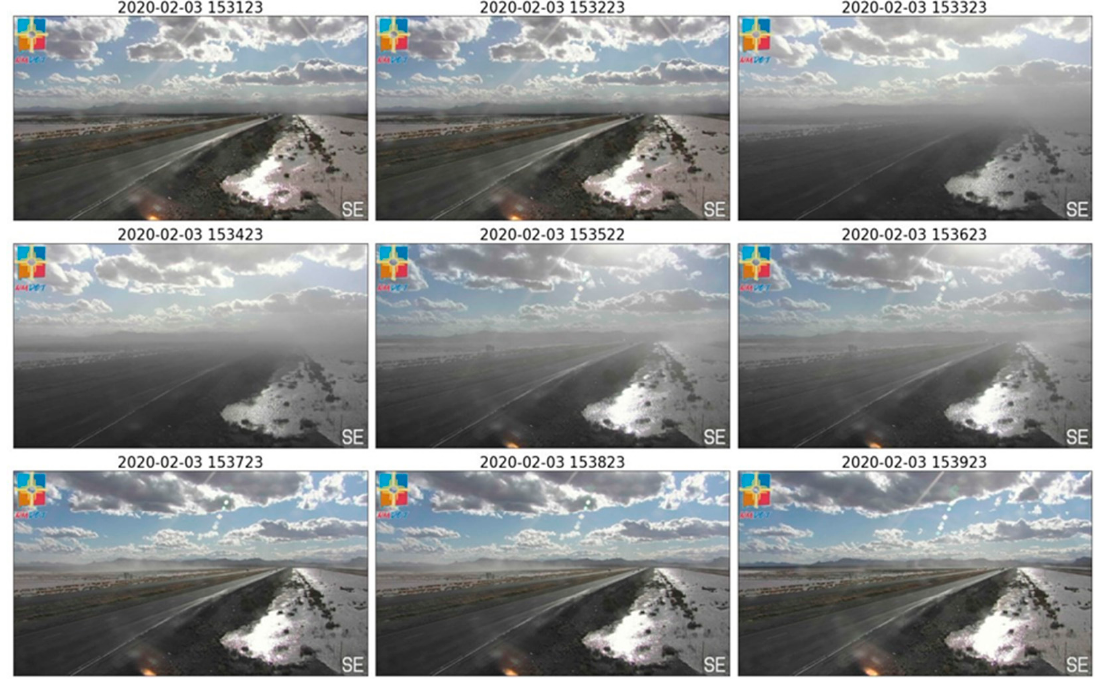
Figure 15. Blowing dust recorded by webcam photos at Lordsburg Playa from NMDOT traffic cameras at Mile Post 11 looking west on 3 February 2020.